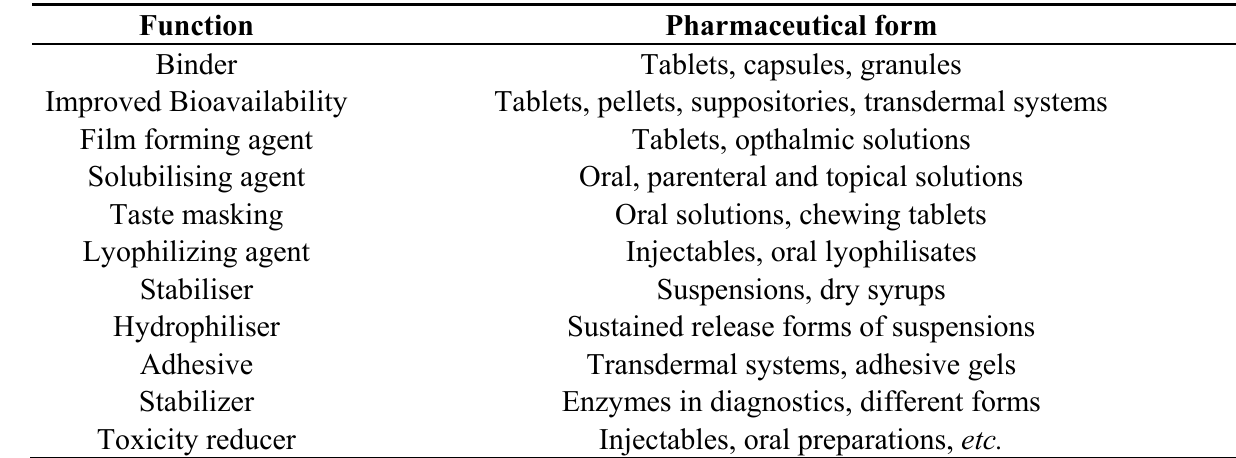
Table 2. The main applications of Povidone